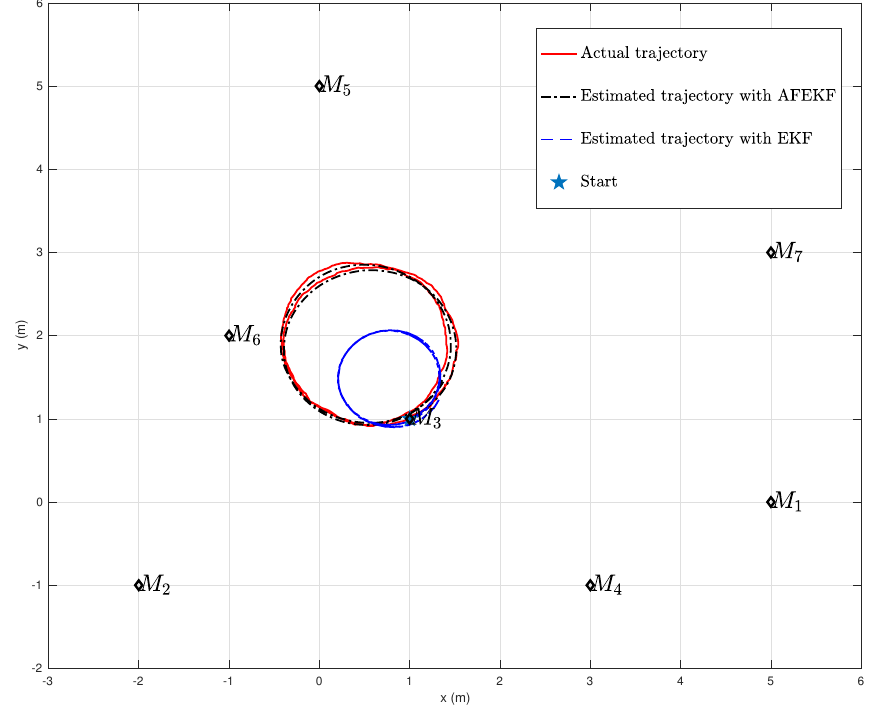
Figure 10. Robot’s trajectory and its estimates under